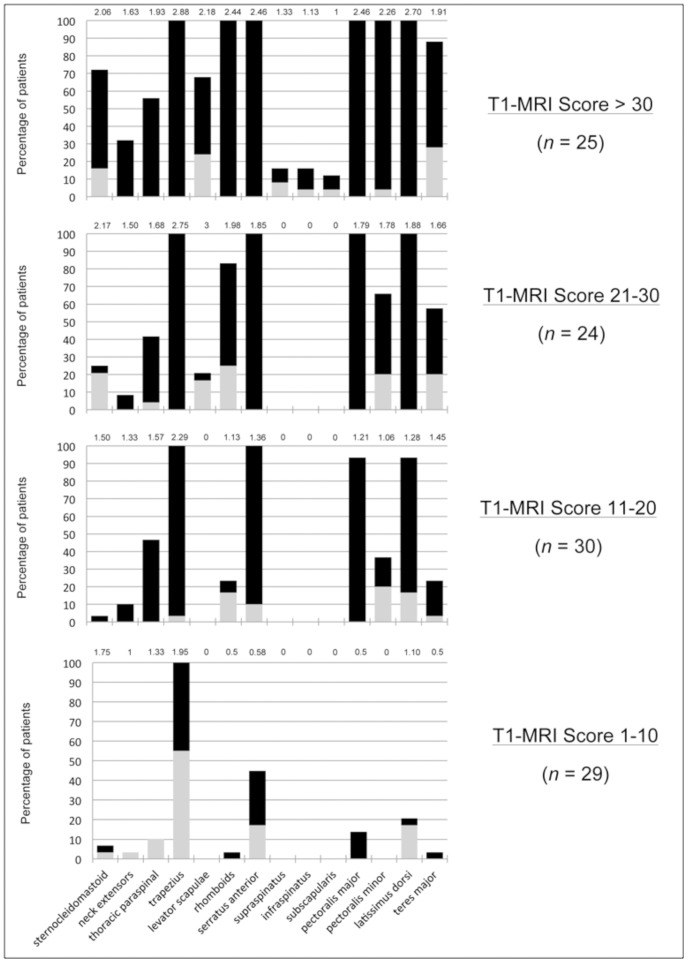
Graphical representation of the distribution of muscle involvement across different disease severities.Patients are subdivided into 4 categories of severity according to the T1-MRI score values. The contribution of the progressive involvement of the different muscles to the T1-MRI score is represented as percentage of patients in whom each muscle is affected monolaterally (gray column) or bilaterally (black column) and mean score for each muscle (number on top of the columns).